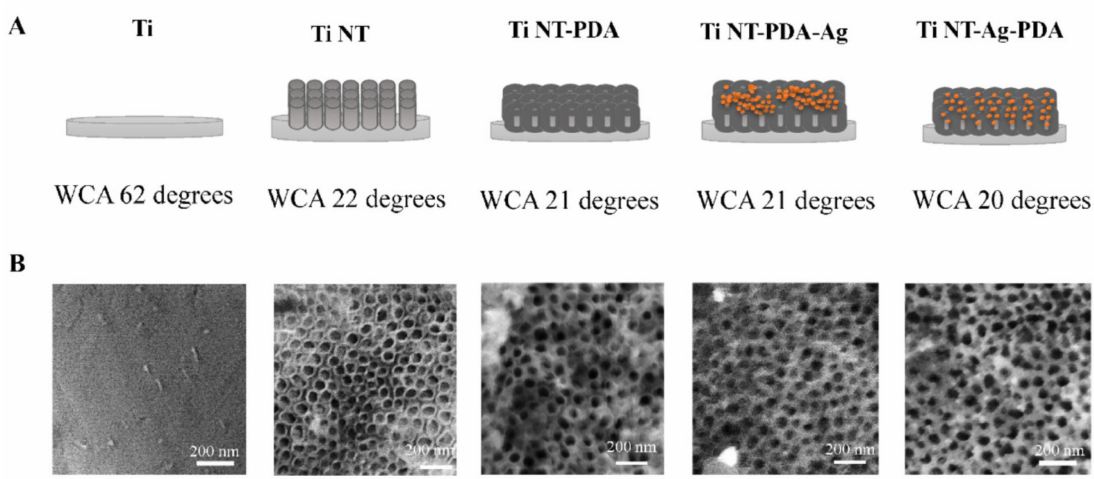
Figure 4. Schematic presentation ( A ) and electron microscopic pictures ( B ) of the different surfaces. WCA: water contact angle. Reproduced from Ref. [26] with permission from